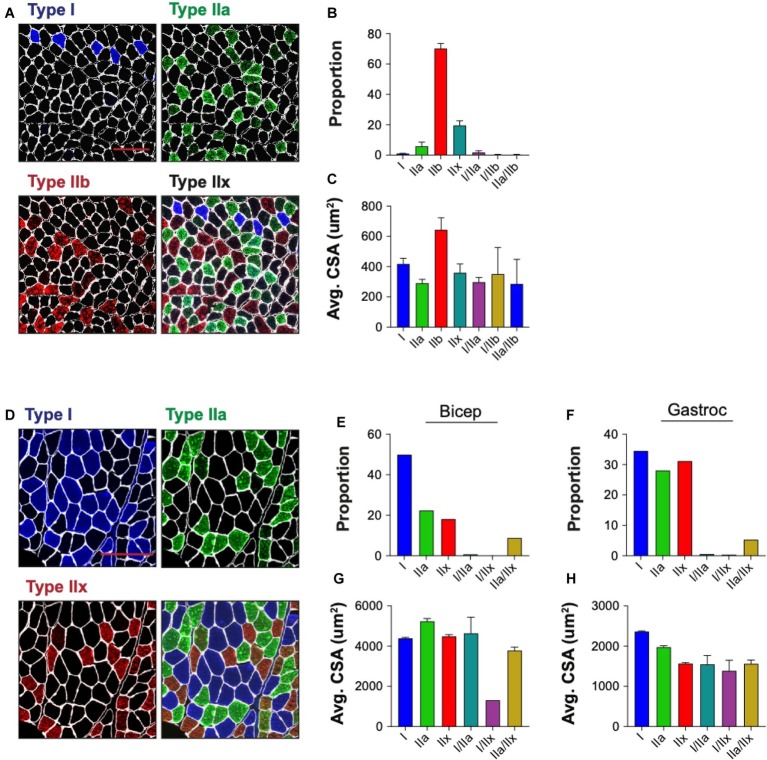
Myofiber typing of mouse and human muscle. (A) Representative image of WT mouse quadriceps cross-sections stained with antibodies against myosin heavy chain-specific isoforms. Blue = type I, green = type IIa, red = type IIb. Fibers with no isoform present are defined as type IIx. (B) The proportion of each myofiber type. (C) The average (Avg) cross-sectional area (CSA) of each fiber type. Data are displayed as the average ± SEM from full section measurements of four WT mice. A total of 25,757 fibers were measured. (D) Representative image of human cross-sections stained with antibodies against myosin heavy chain-specific isoforms. Blue = type I, green = type IIa, red = type IIx. (E,F) The proportion of each fiber type in human biceps brachii (Bicep) or gastrocnemius (Gastroc). (G,H) The Avg CSA of each fiber type in both muscle groups. Data are measured from full cross-sections and are displayed as the average ± SEM CSA of each patient sample (G,H). 1,488 (Biceps) and 2,036 (Gastroc) fibers were measured. Scale bars = 100 (A) or 200 (D) μm.